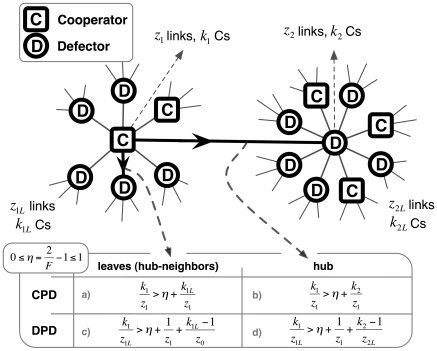
Invasion conditions for a hub-cooperator.From the definitions of the parameters in the figure one obtains that DPD leads systematically to less stringent conditions for invasion of the C (squares) occupying the left hub, explaining the increased success of Cs under DPD. On general heterogeneous populations with average connectivity z0, conditions a) and b), as well as c) and d), show that it is easier to invade a D (circles) on a leaf than in the center of another hub. This invasion creates a positive feedback resulting from cooperative “leaves” surrounding the left hub (k1 - k2 increases) allowing a subsequent invasion of the right hub.